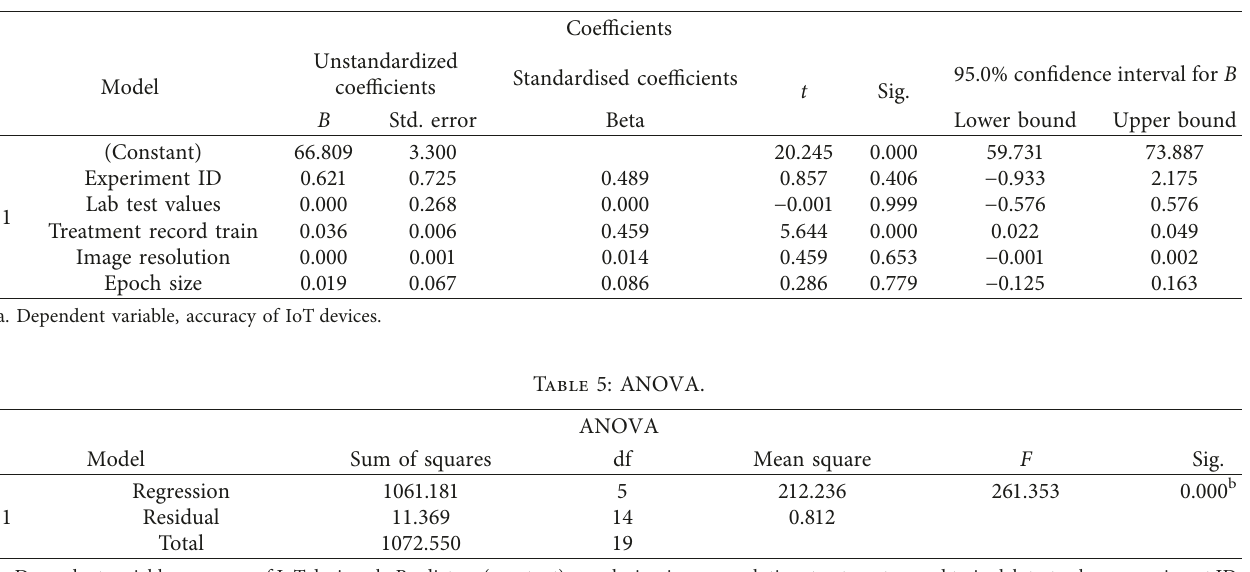
Figure 7: Histogram analysis of accuracy by doctors. Table 4: Regression analysis 2.